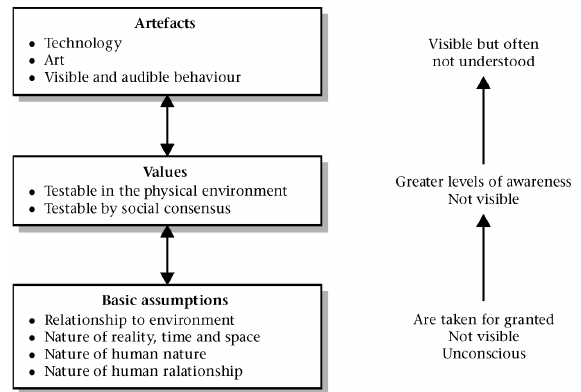
Figure 1: Schein’s Levels of Culture Adapted from Schein (1985,